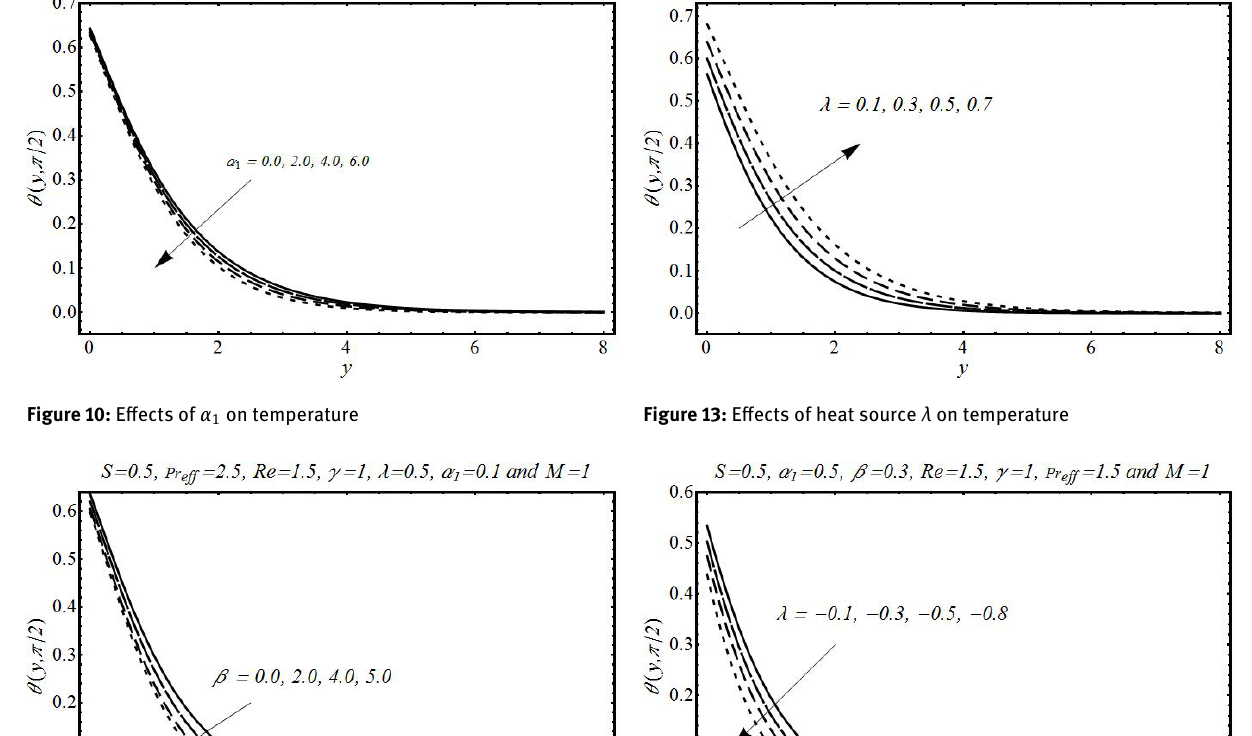
Figure 14: Effects of heat sink λ on temperature